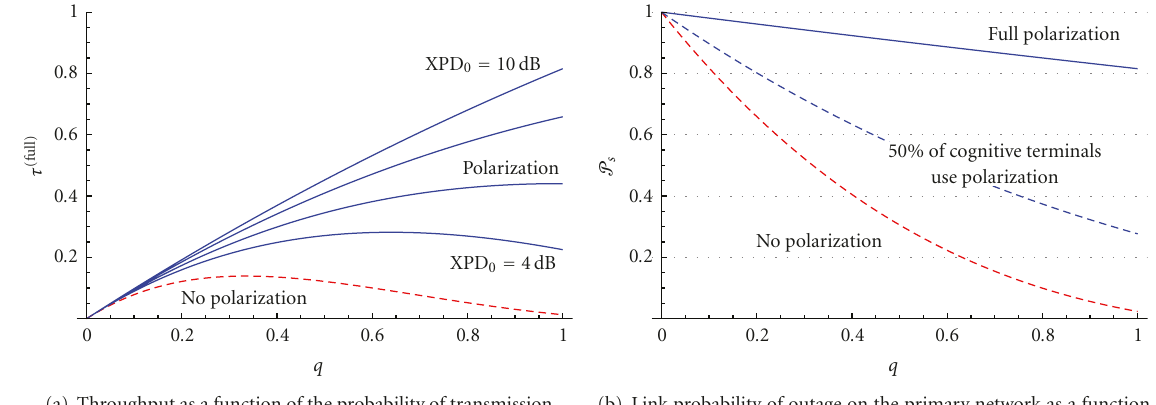
(b) Link probability of outage on the primary network as a function of the probability of transmission Figure 11: Performance analysis of a dual-polarized full-duplex cellular system.